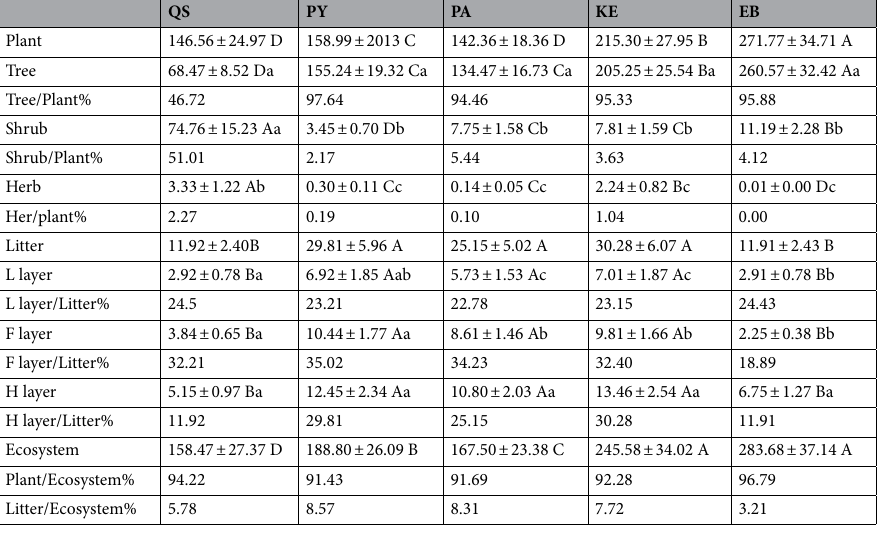
Table 2. Biomass (t ha −1 ) and proportion (%) of plant components and the litter layer in various forests in the central Yunnan Plateau. Mean values ± standard deviations are illustrated; Different lowercase letters in each row indicate significant differences ( P < 0.05 ) among the plant components and litter layer, and different capital letters in each line indicate significant differences ( P < 0.05 ) among forests.